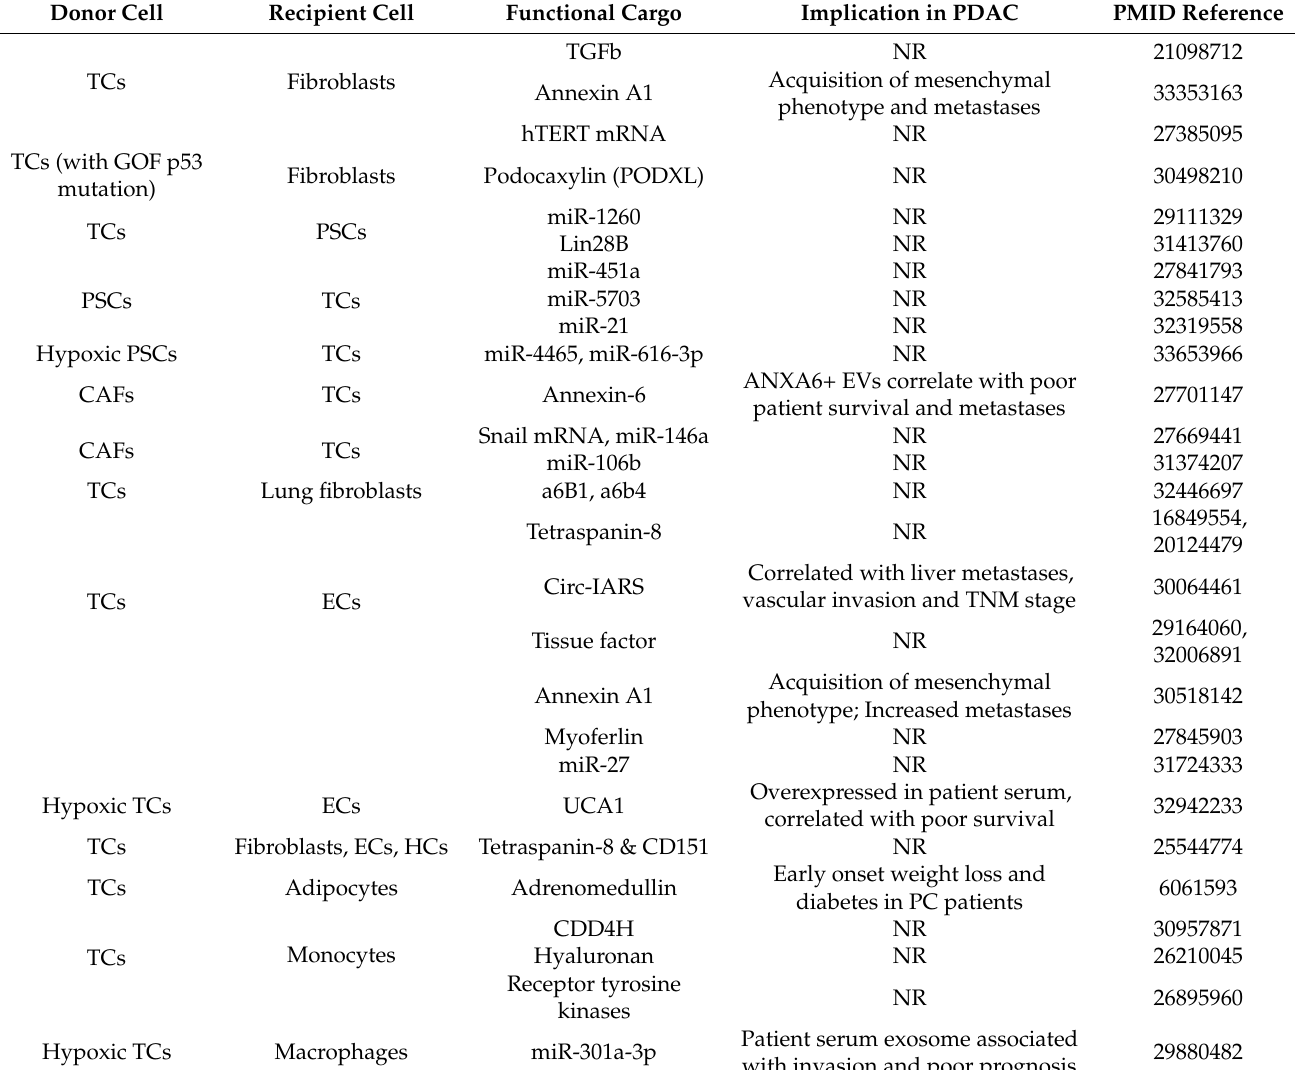
Table 2. Tumor cell and stromal cell crosstalk mediated by